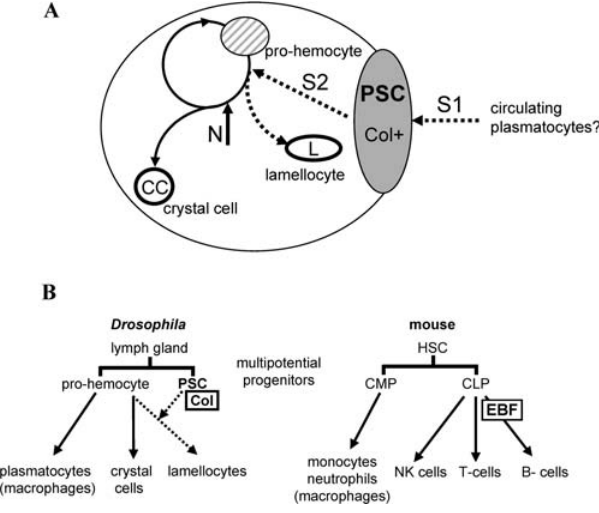
Figure 6. A Model for Lamellocyte Specification (A) A model for the induction of lamellocyte differentiation in the Drosophila lymph glands in response to wasp parasitization.